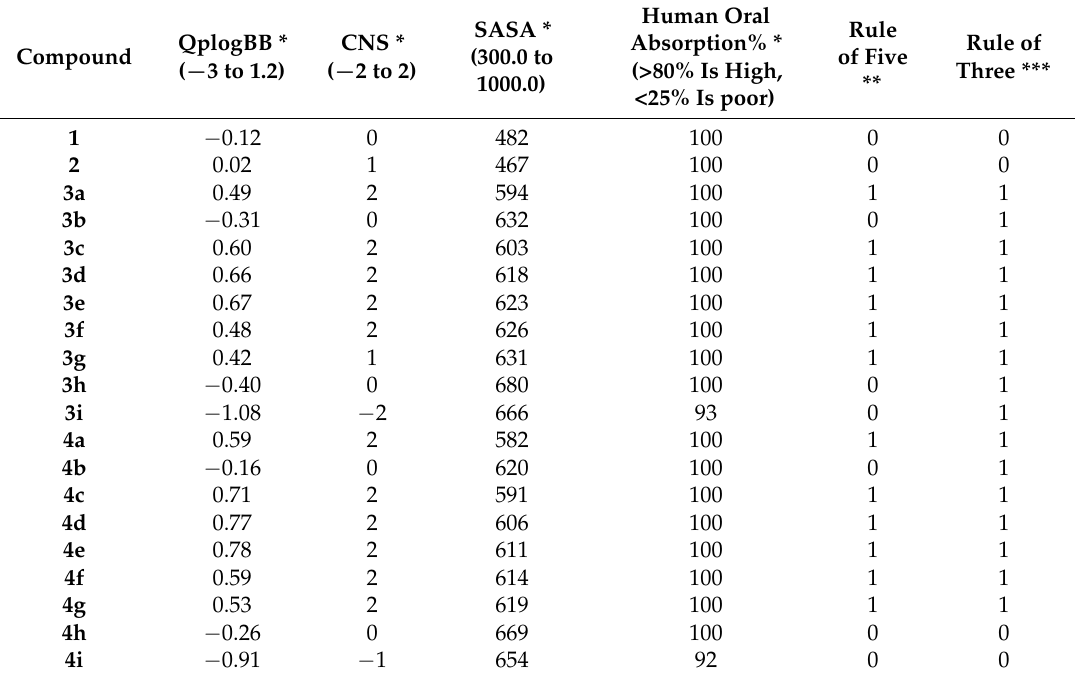
Table 3. Predicted ADME properties of compounds 1 , 2 , 3a – i , and 4a – i